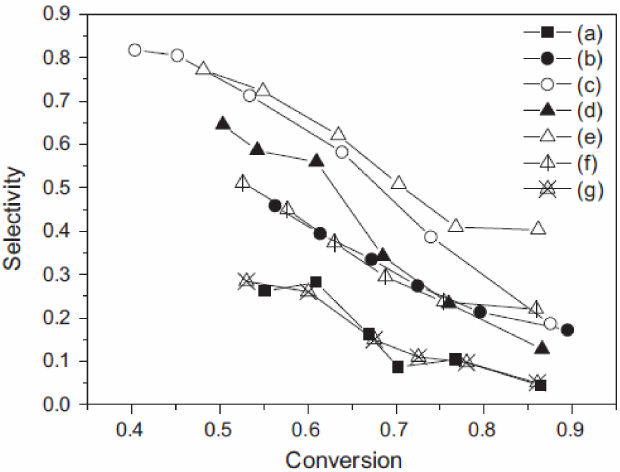
Figure 11. Performance of various Ti-modified Pd–La catalysts in acetylene hydrogenation. (H 2 /Acetylene = 2, reaction temperature = 60 ◦ C). (a) Pd/300, (b) Pd–1La/300, (c)